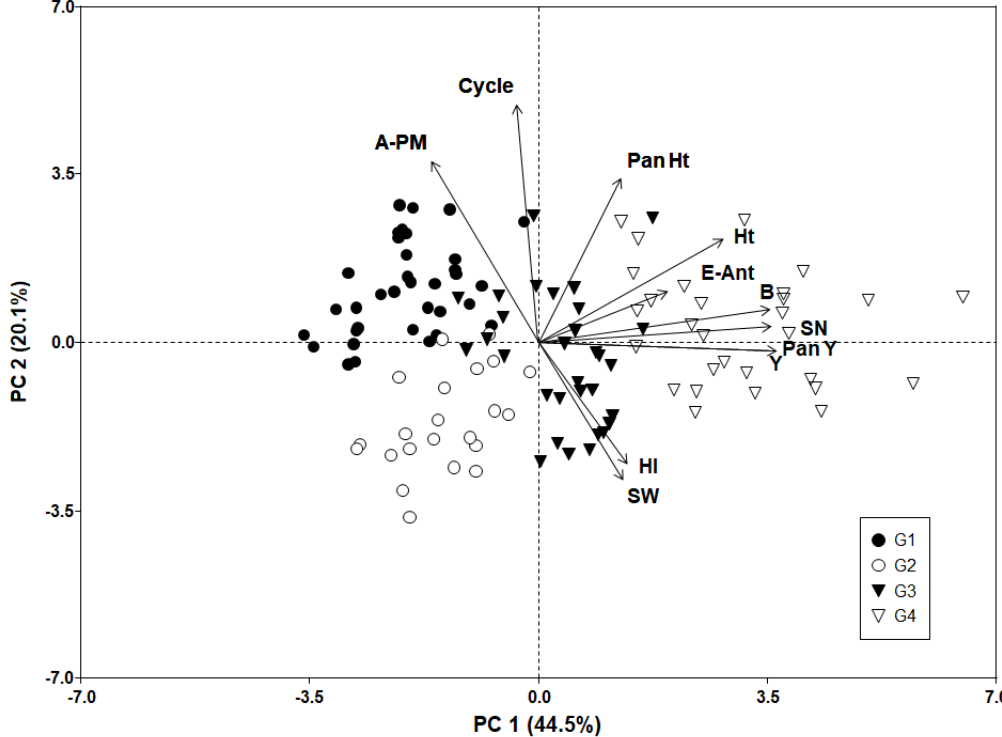
Figure 2. Biplot of the 1st and 2nd principal components for 117 accessions of quinoa described by